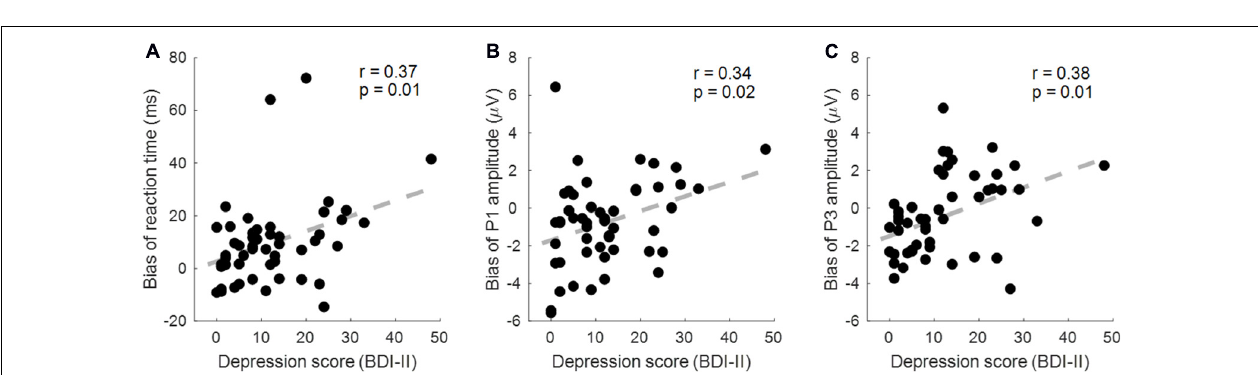
FIGURE 4 | The grand-mean event-related potential (ERP) waveforms of P3 component in the two groups (data averaged at the parietal electrode site of Pz, P3, P4, CP1, and CP2).